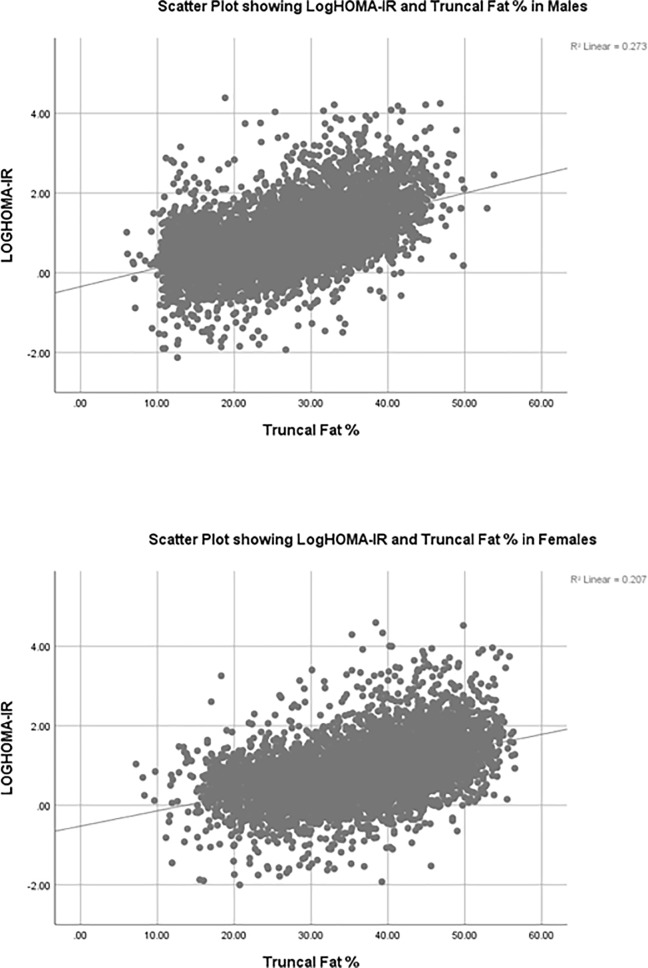
The scatter plots outlining the relationship between log HOMA-IR and trucal fat % in males and females).